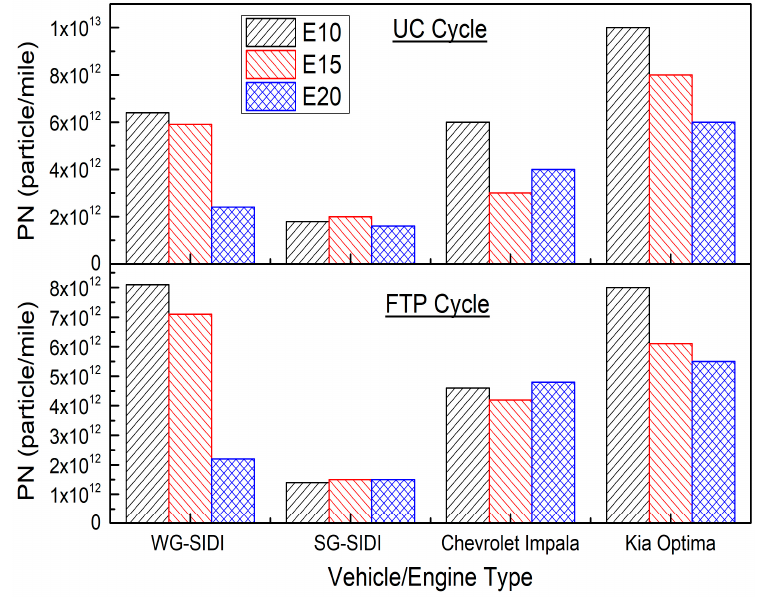
Figure 9. Impact of ethanol fuel blends on PN emissions (data from [1,85]).